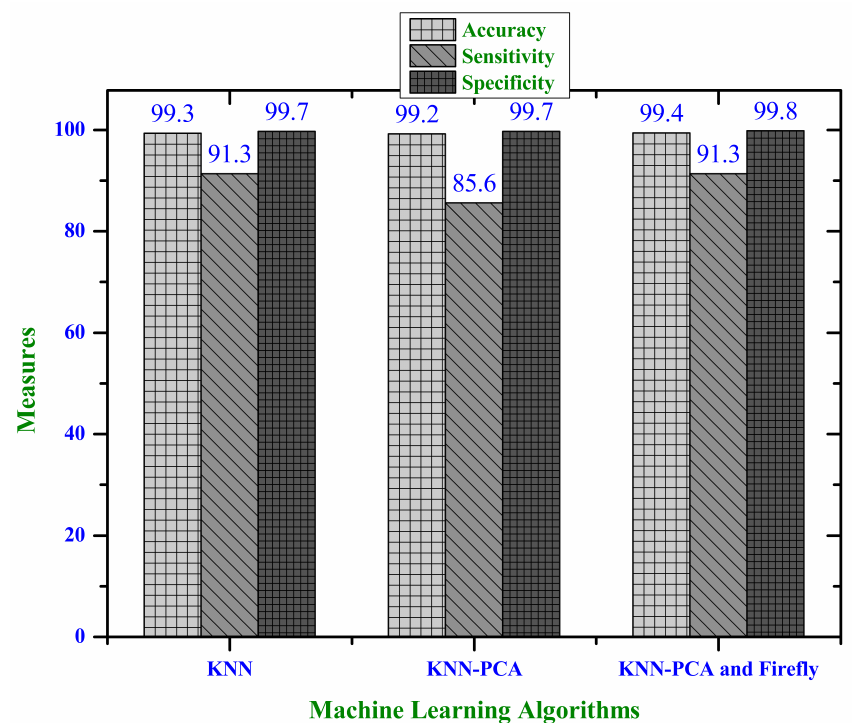
Figure 4. Performance evaluation of KNN classifier.